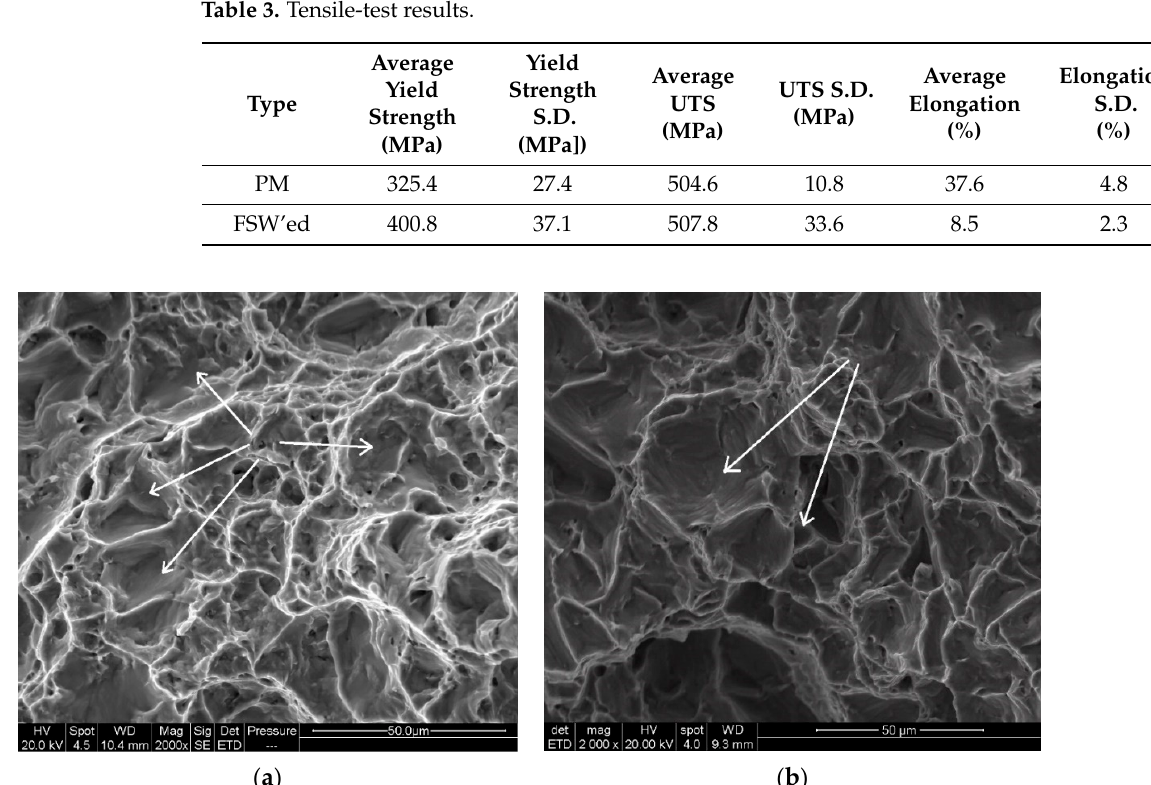
Figure 8. SEM micrographs of the fracture surface of broken tensile specimens: ( a ) parent material; ( b ) FSWed specimen. ( b ) FSWed